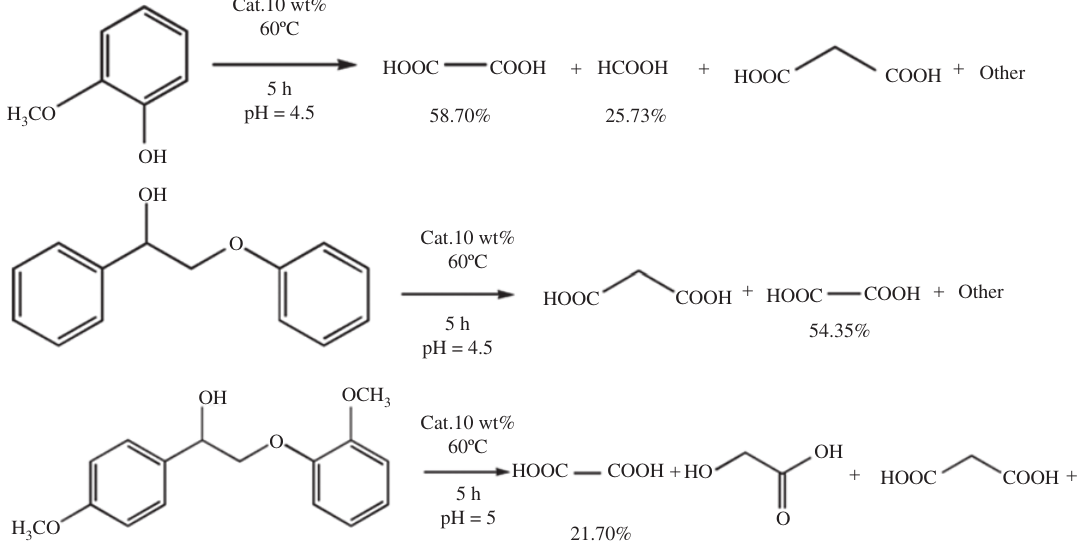
Scheme 1: Degradation of model compounds to oxalic acid.